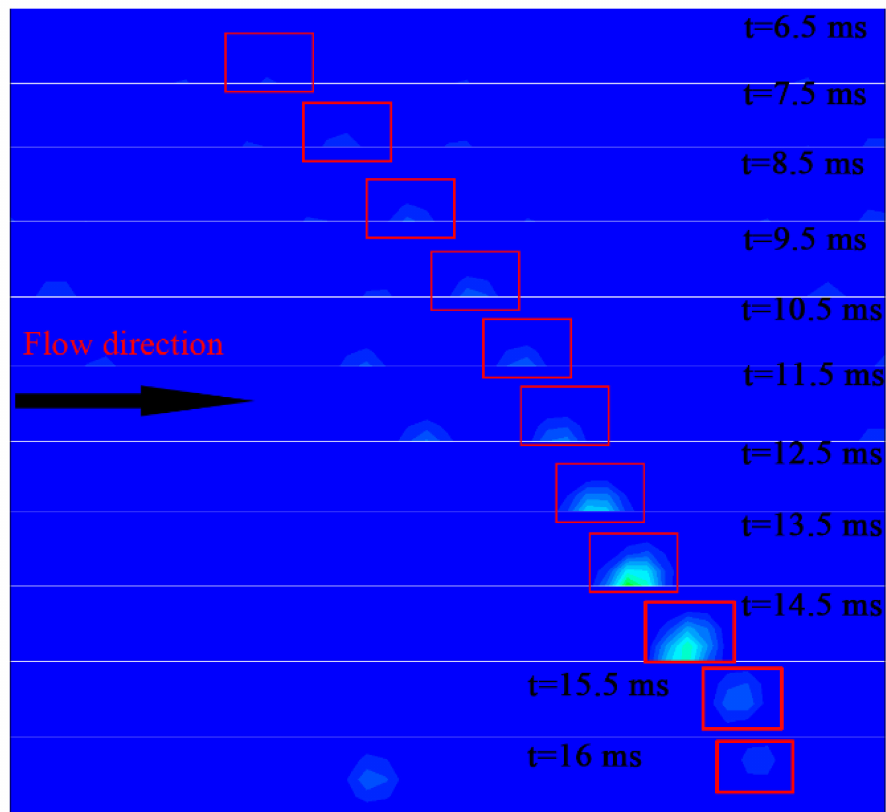
Figure 3. The developing process of the sliding bubble with